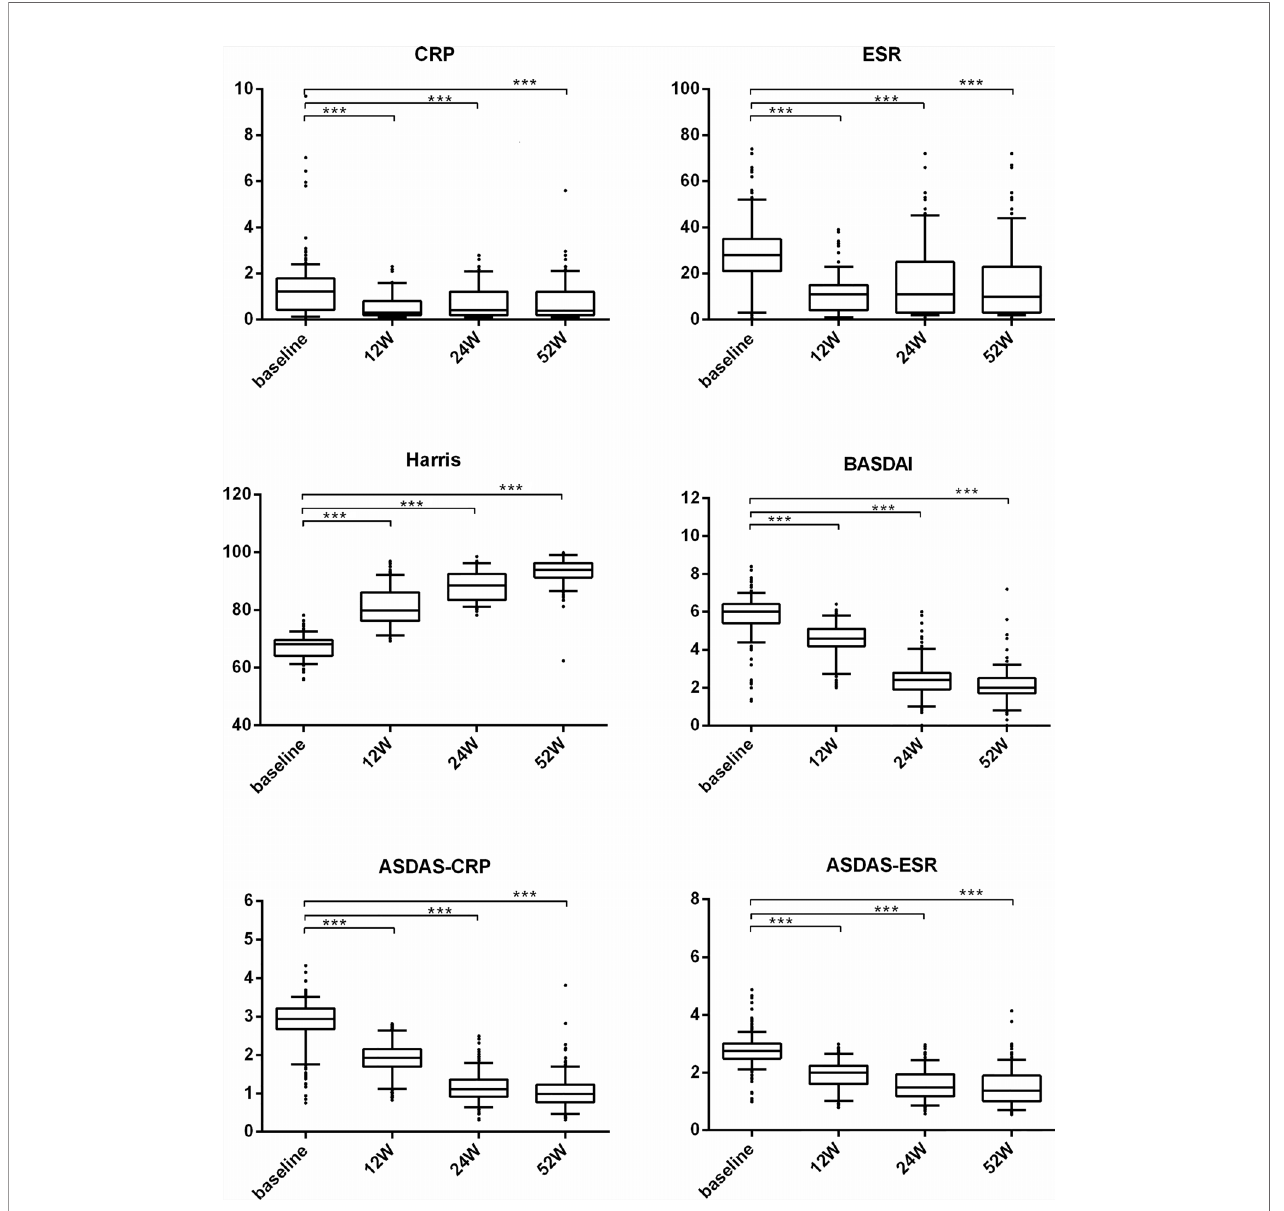
FIGURE 3 | The clinical performance of TNF- a inhibitor group from baseline to week 52. For each box-and-whisker plot, the whisker represents the range, the box represents the 5th – 95th percentile, the solid lines within the box represent the mean values of clinical indexes, ***p <